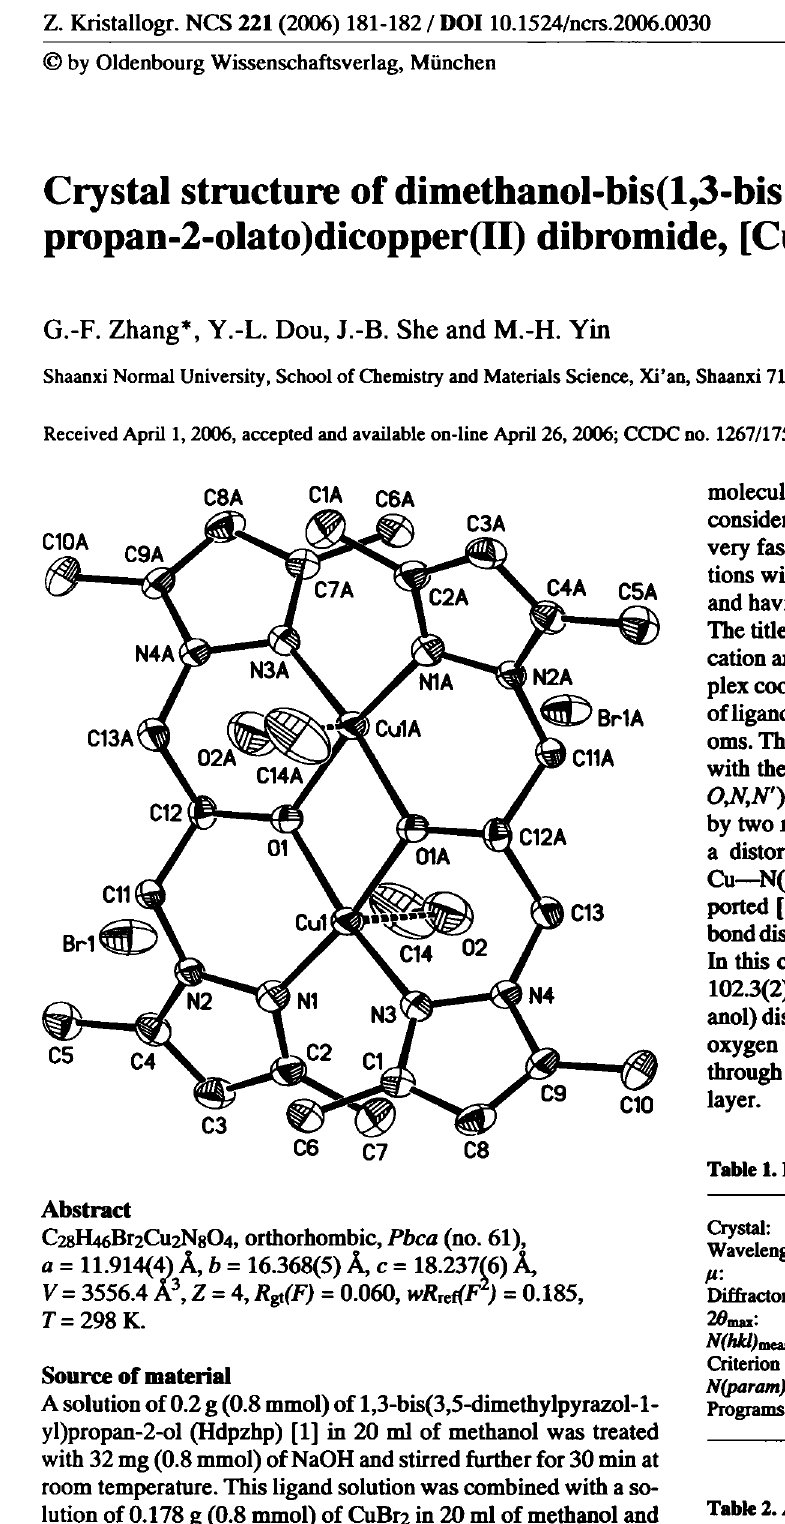
Table 2. Atomic coordinates and displacement parameters (in A 2